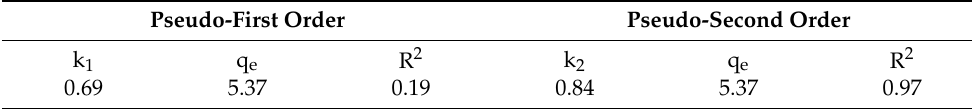
Table 1. Kinetic parameters for As(III) adsorption onto FeOOH coated sand.